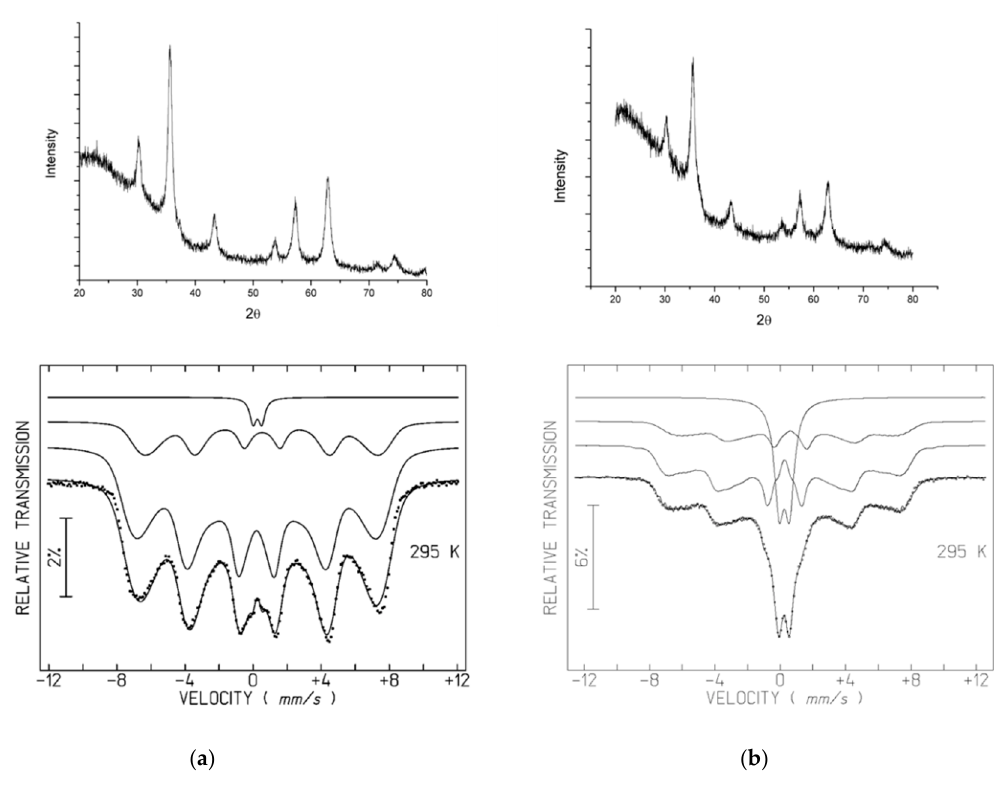
Figure 5. XRD diffractograms and Mössbauer spectra of coated SPIONs (Samples C): ( a ) C1.1, ( b ) C4.1.